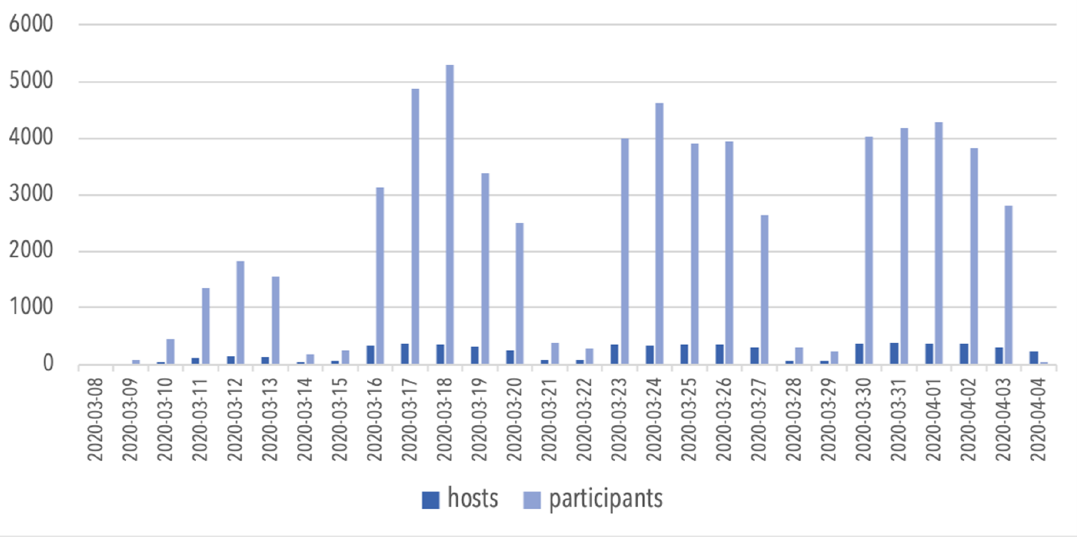
Figure 8. Sum of hosts and participants per day at the university-wide video conferencing system